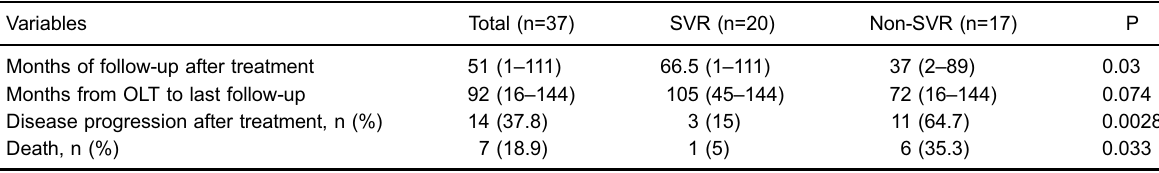
Table 4. Clinical outcome after recurrent HCV